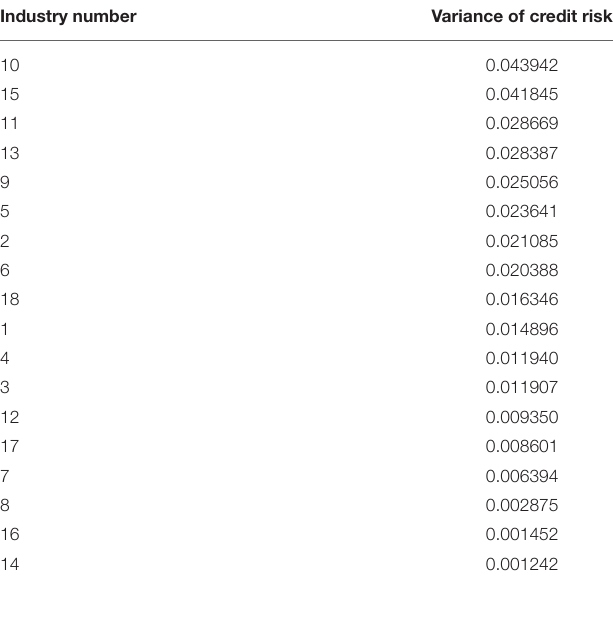
TABLE 1 | Statistical table of variance of credit risk of each real industry.